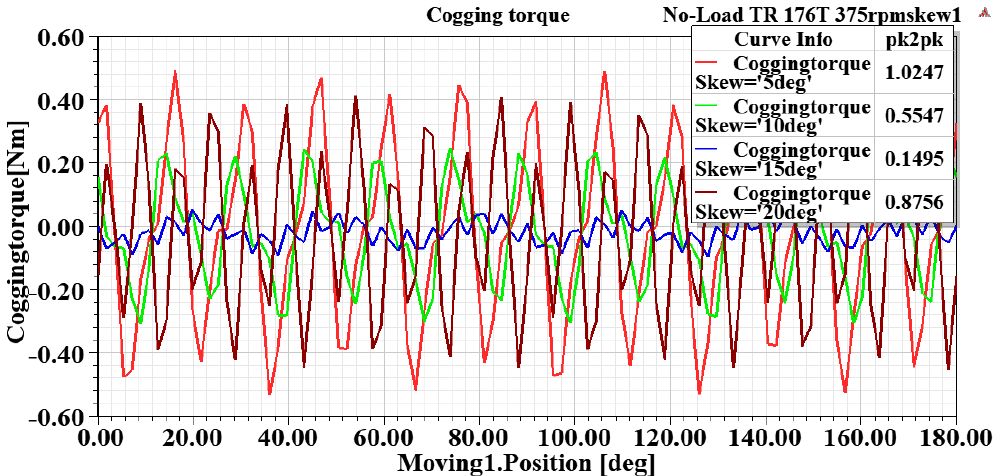
Figure 22. The effect of cogging torque for various skew angles.